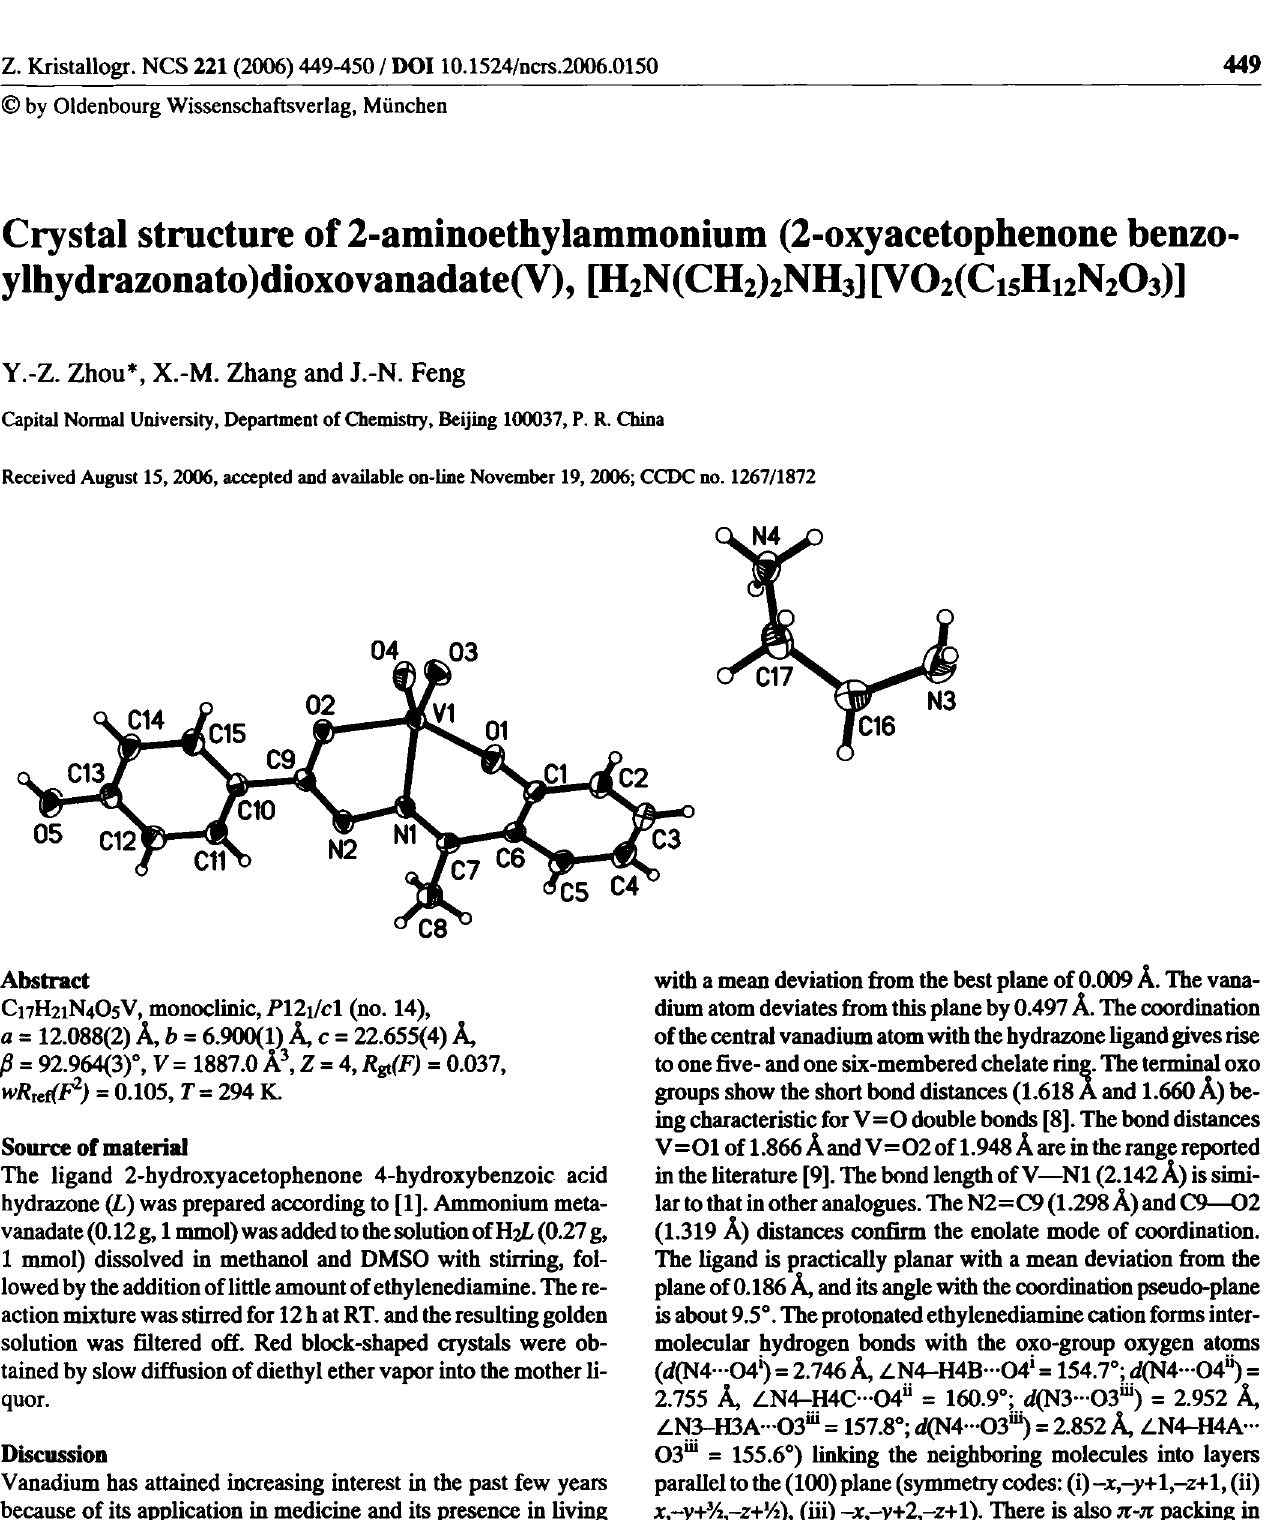
Table 1. Data collection and